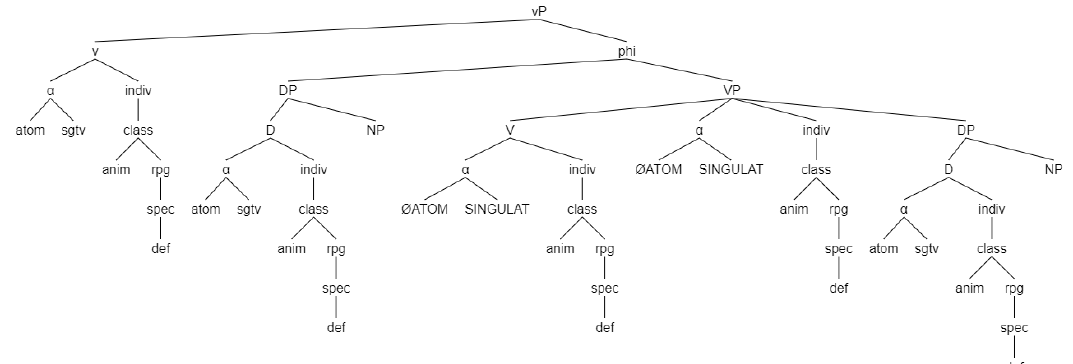
Figure 27. After insertion of v*, inheritance, Agree, and labeling.